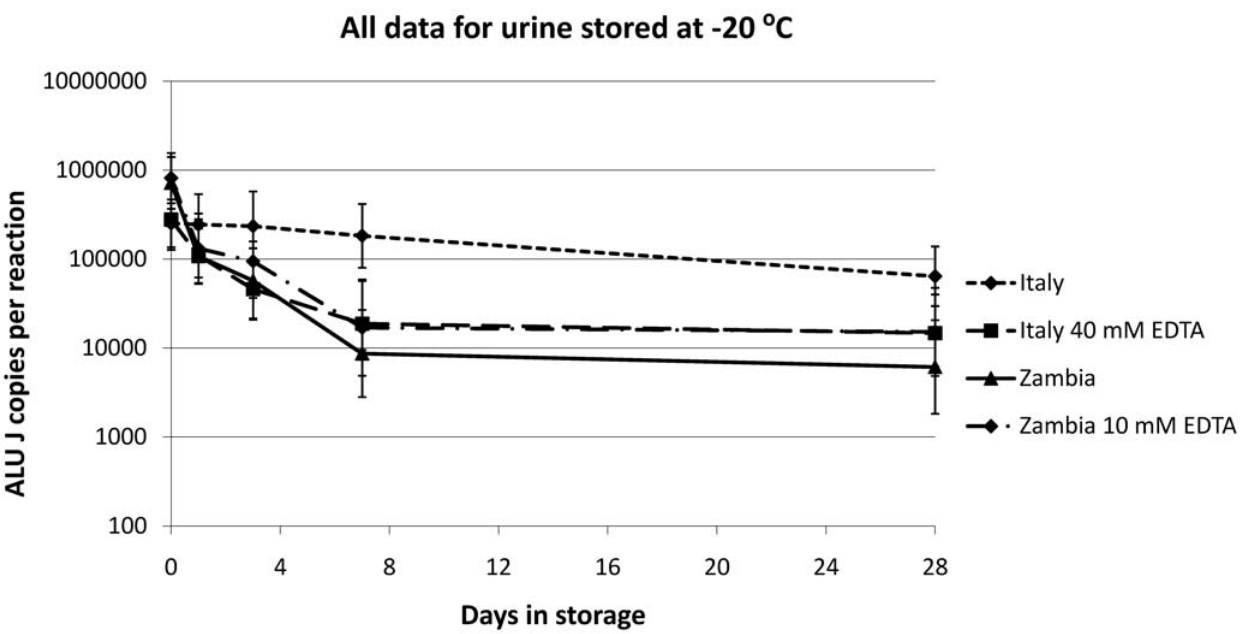
Figure 4. Direct comparison of human DNA stability in samples stored at 2 20 u C over 28 days. The Italian urines stored with 40 mM EDTA at 2 20 C show the same biphasic degradation of human DNA observed in all Zambian urines. This biphasic degradation of the Zambian urines occurs in both the presence and absence of EDTA. Geometric means + / 2 95% confidence intervals are plotted for each treatment.